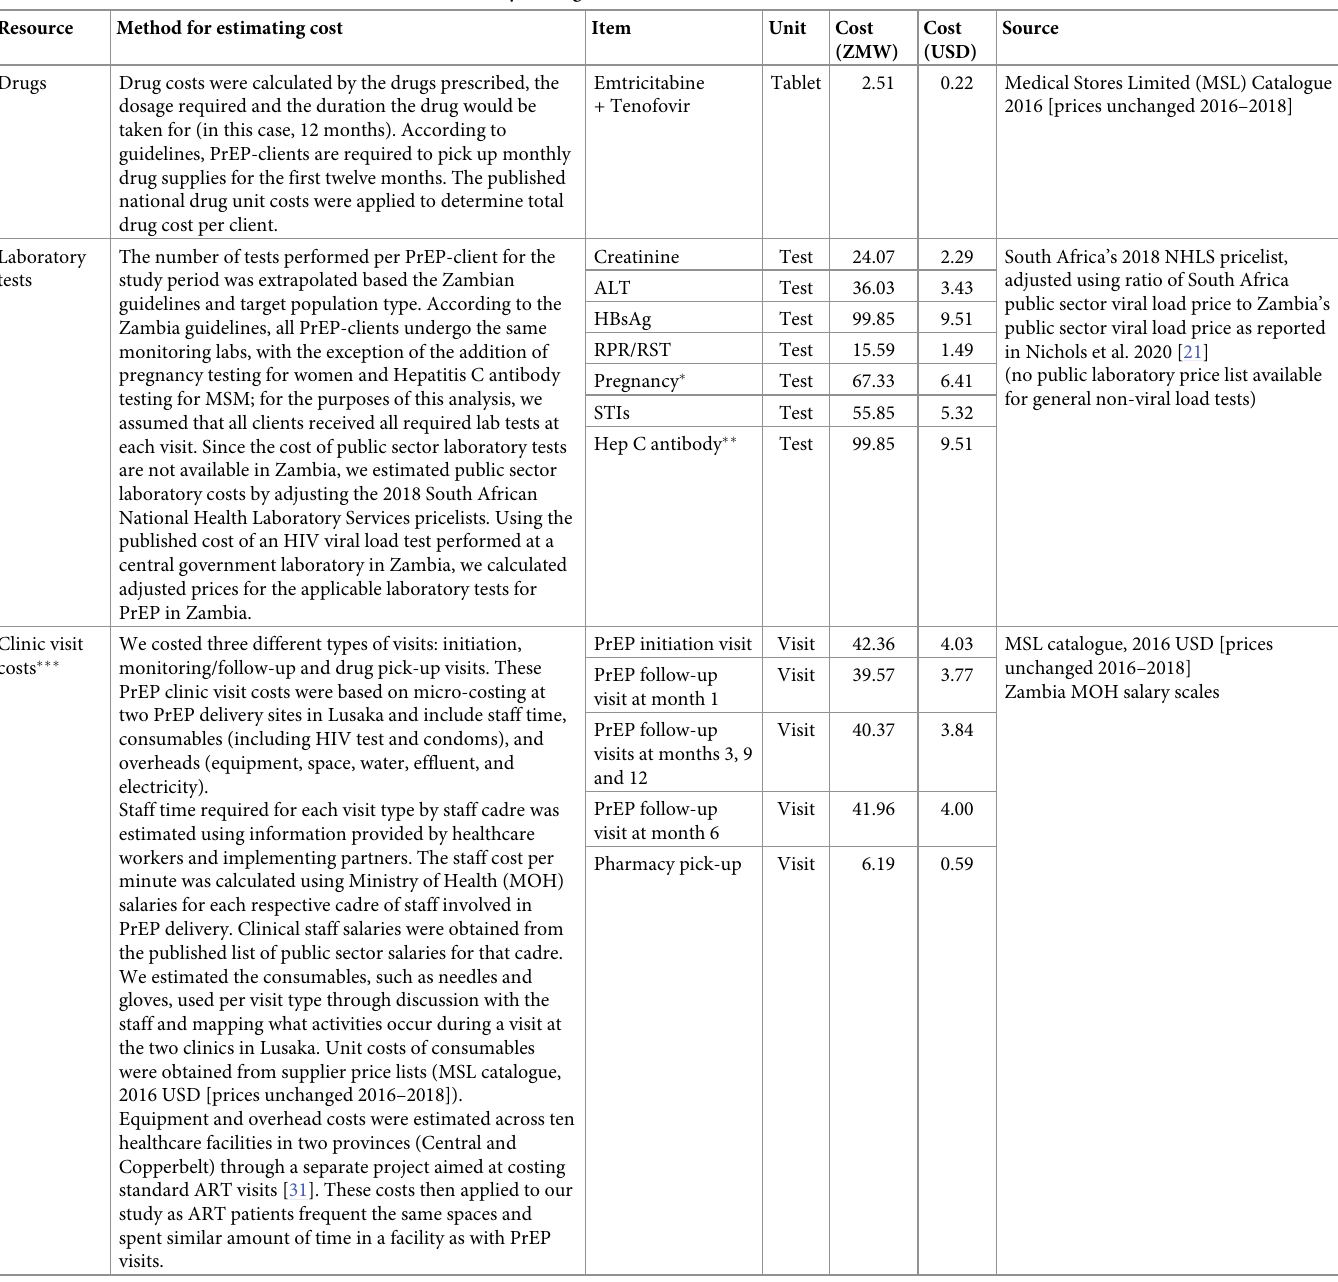
Table 3. Cost methods and unit costs for direct service delivery